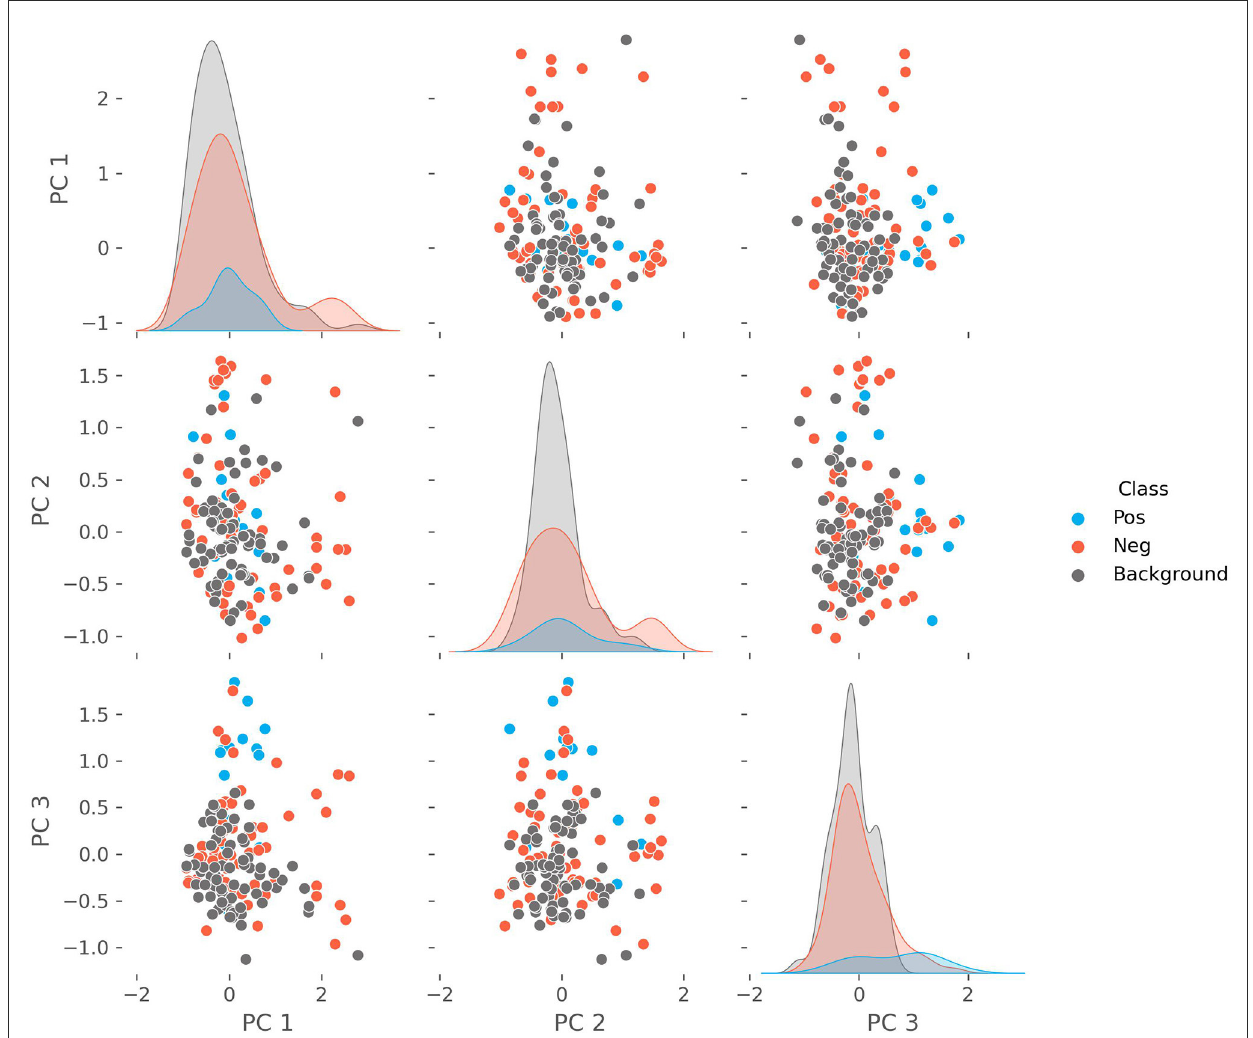
FIGURE3 The pairwise plots of the first three principal components alongside their respective densities of a principal component analysis performed on the combined positive, negative, and background cohorts. The features with the largest contributions to the variance of the first principal component (PC1) are: “Fatigue, Headache, Lower Back Pain”; to the PC2: “Splenomegaly, Hepatomegaly, Fatigue”; and to the PC3: “Fatigue, Myalgia,